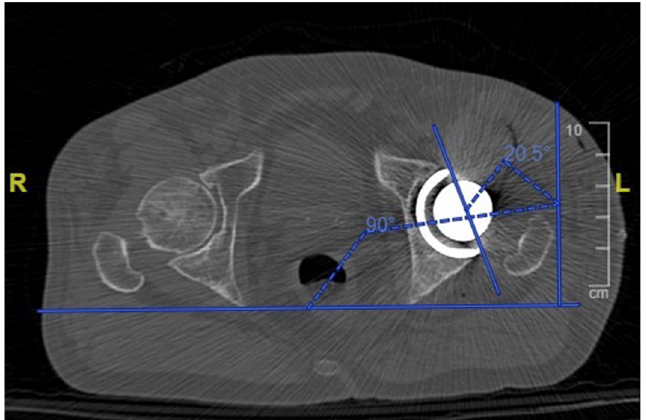
Figure 6. Measurement of the acetabular cup anteversion angle on a postoperative CT scan .